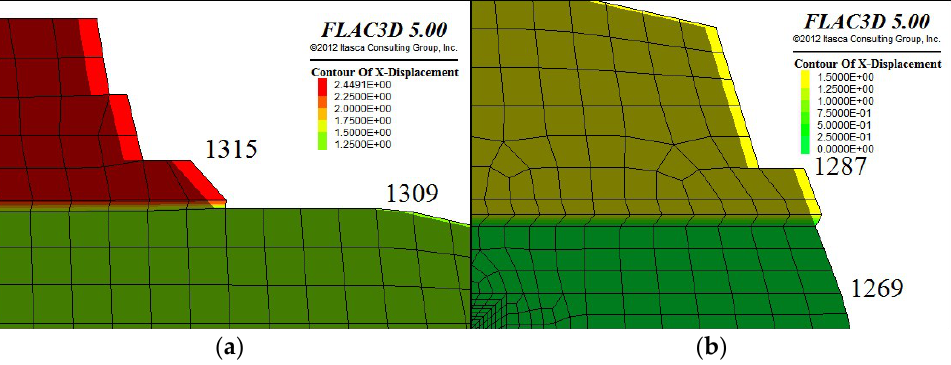
Figure 12. Numerical simulation of weak-plane slipping at an advancing distance of 180 m. ( a ) Weak plane 1310; ( b ) weak plane 1280.